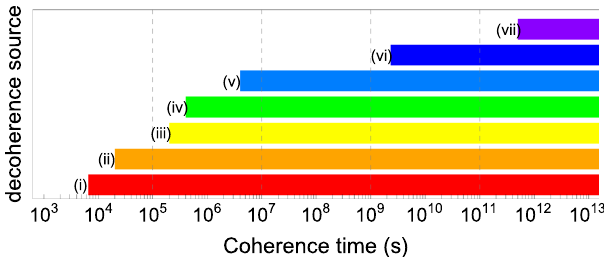
Fig. 6 Expected limitations of coherence time. The left boundaries of different color-bars indicate expected limitations caused by corresponding decoherence sources as follows: (i) Phase noise of local oscillator; (ii) Magnetic- fi eld fl uctuation; (iii) Ion hopping; (iv) Scatting of 138 Ba + lasers; (v) Leakage of the microwave; (vi) Collision of background gas; (vii) Lifetime of hyper fi ne ground-state. Currently, the coherence time is mainly limited by the phase noise of the local oscillator and the ultimate coherence time limited by the lifetime of the hyper fi ne state is estimates as around 5 × 10 11 s.